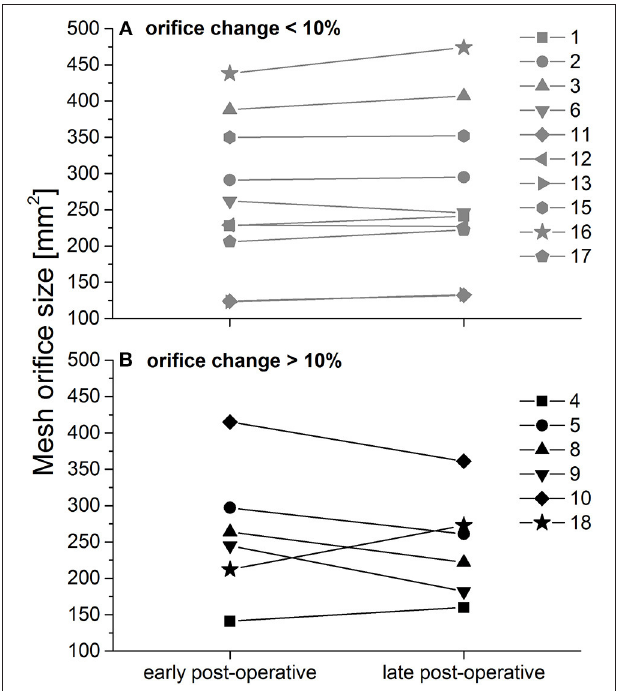
FIGURE 4 | Calculated peri- and post-operative esophageal orifice size. (A) Patients with size change < 10%; (B) Patients with size change > 10%, as published in ( 4) with permission.